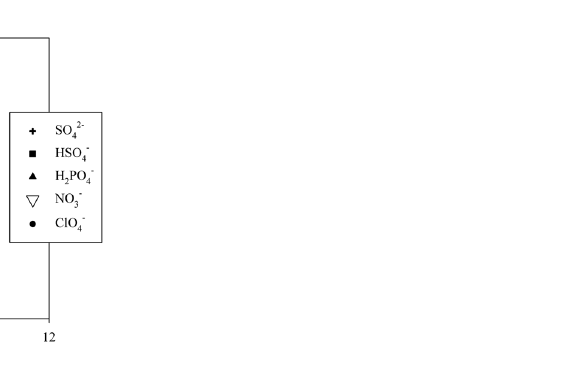
3 Scientific REPoRts | 7: 6032 | DOI:10.1038/s41598-017-05831-x